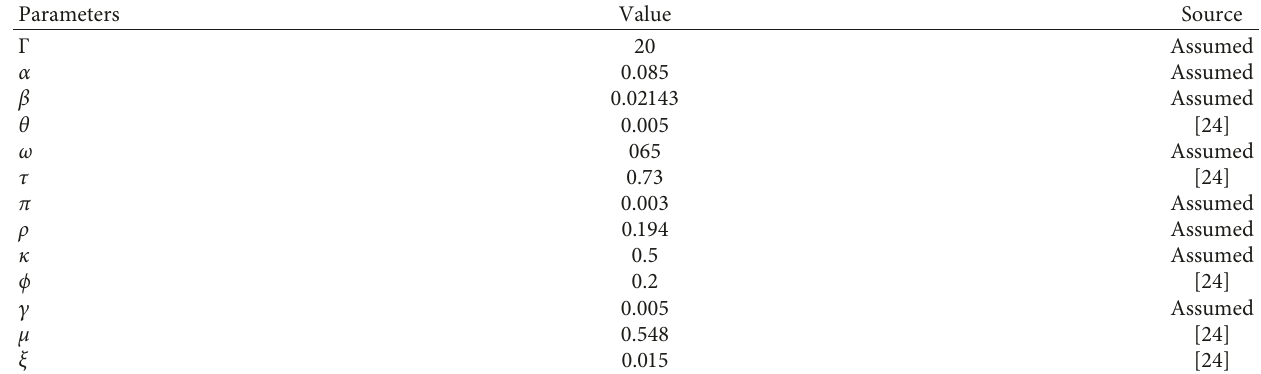
Table 1: Parameter values for cholera model.